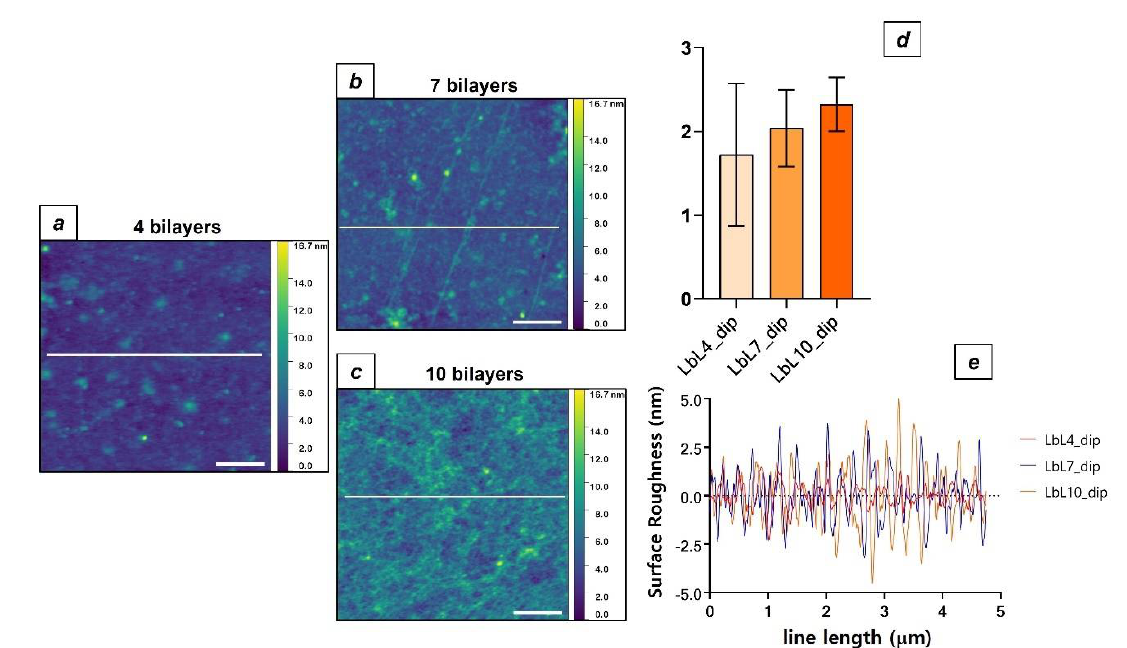
Figure 4. AFM topographical analysis of LbL assembly by dip coating. AFM scan of LbL surface after the deposition of 4 ( a ), 7 ( b ), and 10 ( c ) bilayers. ( d ) Average surface roughness of LbL multilayers with increasing number of bilayers deposited onto PI surface. ( e ) Plot of surface roughness profile of dip-coated LbL substrates relative to the white line drawn in each AFM scan. Scale bars are 1 μm.